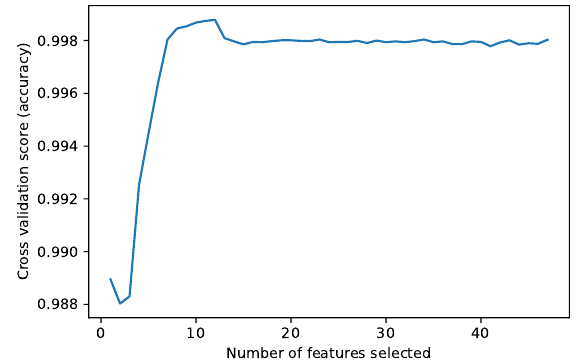
Figure 1. Accuracy versus variable